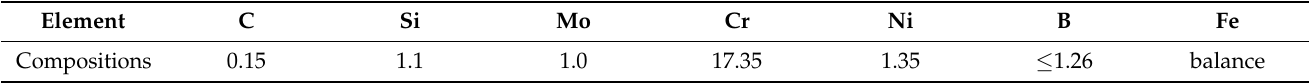
Table 1. Chemical composition of iron-chromium alloy powder